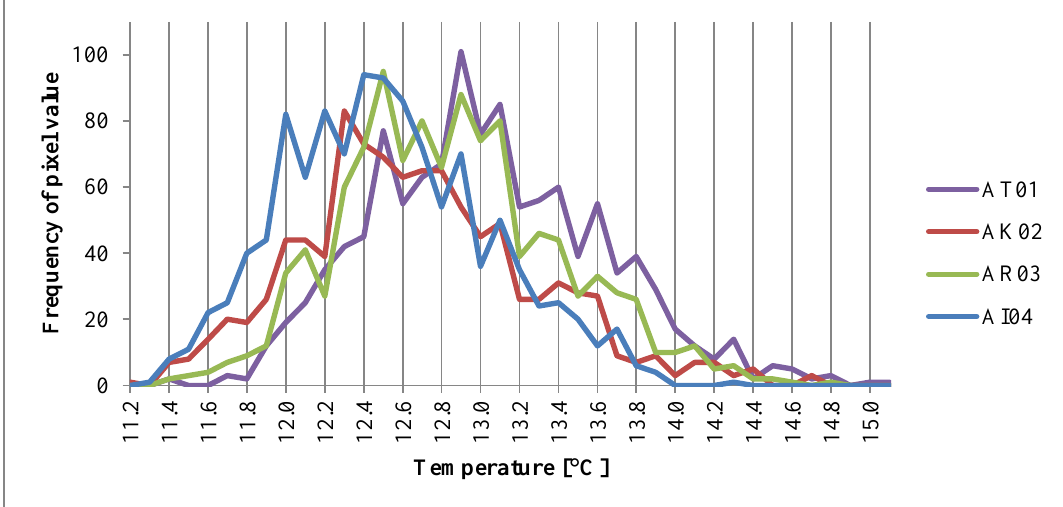
Figure 7. Histogram of measured temperature [°C] of different sugar beet types in plot batch 2 (see Figure